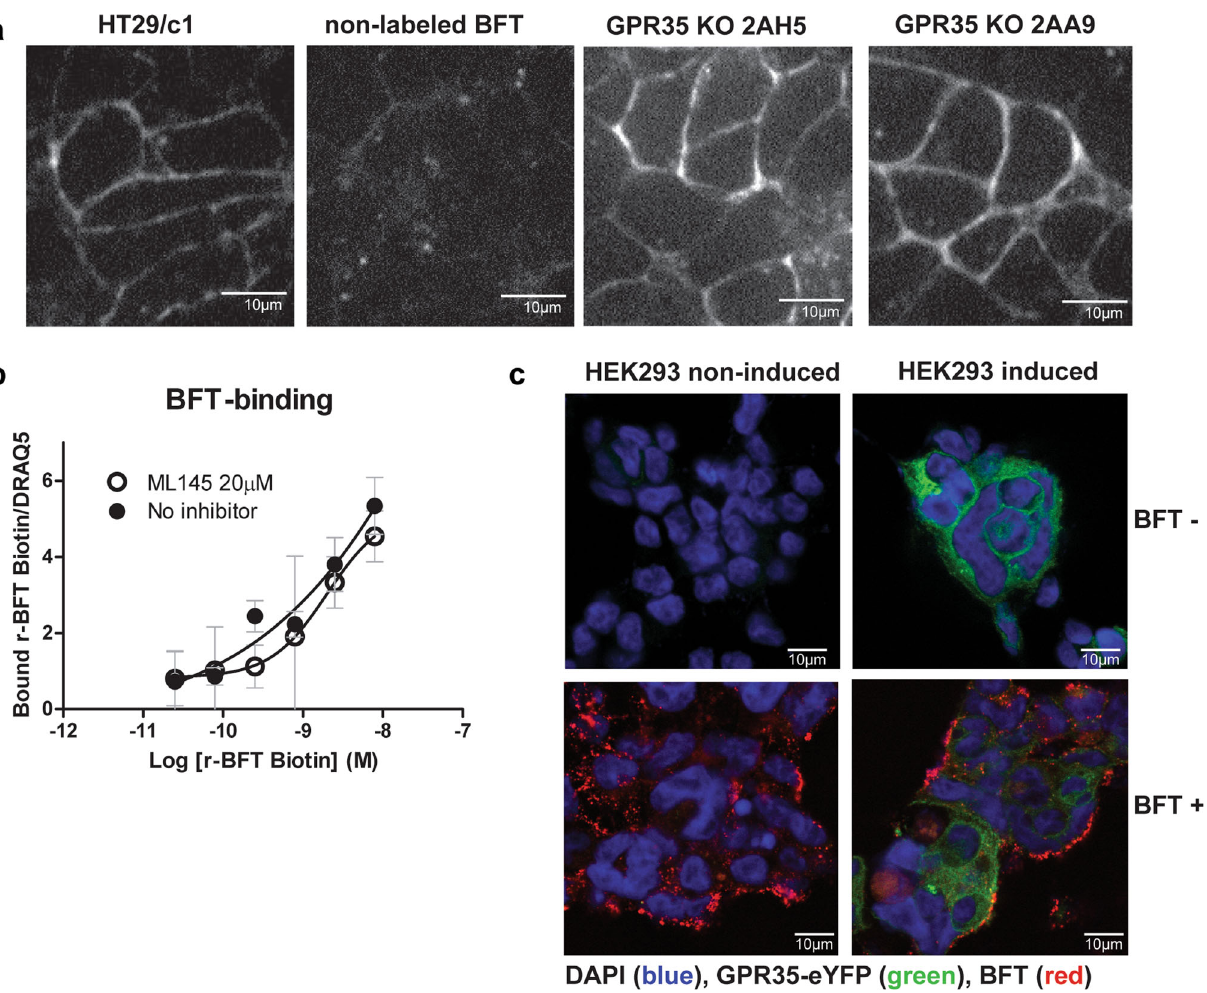
Fig. 5 GPR35 does not facilitate BFT binding to CECs. a HT29/c1 WT, GPR35 KO 2AH5, and GPR35 KO 2AA9 cells incubated with alexa488-labeled BFT. Blocking of 488-labeled binding with non-labeled BFT was used to show the speci fi city of the BFT – CEC binding. Images at ×600 magni fi cation. b Binding of concentration series of biotin-labeled recombinant BFT to HT29/c1 epithelial cells and cells treated with 20 μ M ML145 (NS). c BFT binding to HEK293 cells noninduced or induced to express human GPR35-eYFP. The nucleus is stained with DAPI (blue), BFT (red), and GPR35-eYFP (green). Images at ×400 magni fi